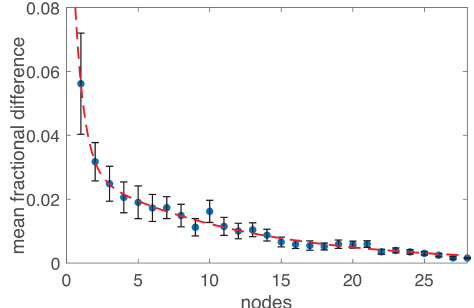
Figure 12. Fractional difference between the Bay Area network me- dian calculated from all Bay Area sites and the network median calculated from a subset of between one and 26 nodes. A random subset of n = 1–26 nodes were selected to calculate the mean frac- tional difference between the network median CO 2 and the median calculated using the subset. This was repeated 100 times for each of n = 1–26 nodes. The reported fractional difference and error bars are the average and 95% confidence interval of the mean fractional difference from the 100 random